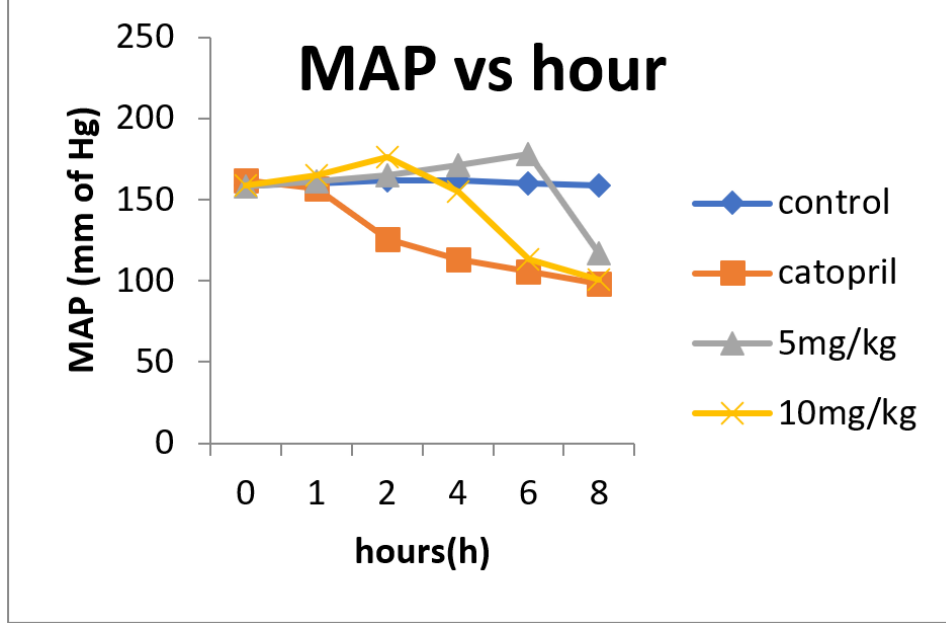
Figure 16. Decrease in mean arterial pressure (MAP) in hypertensive rats. The chickpea bioactive peptide at 10 mg/kg dose at 8 h ( − 53 mmHg) after